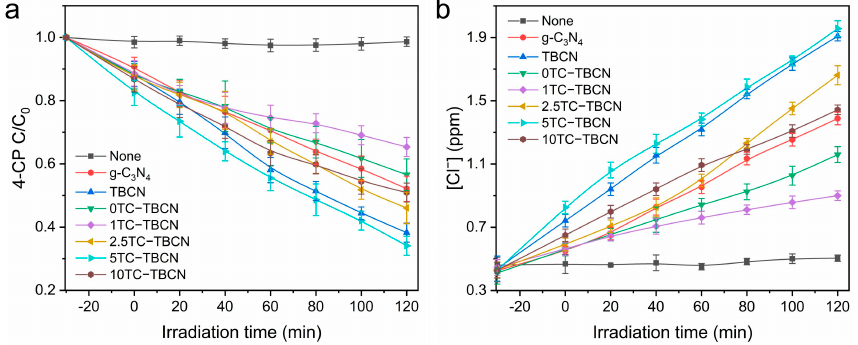
Figure 10. ( a , b ) Time profiles of 4-CP and Cl − concentration during 4-CP removal in the presence of different photocatalysts under light irradiations: [catalyst] = 0.5 g/L; [4-CP] 0 = 10 ppm.